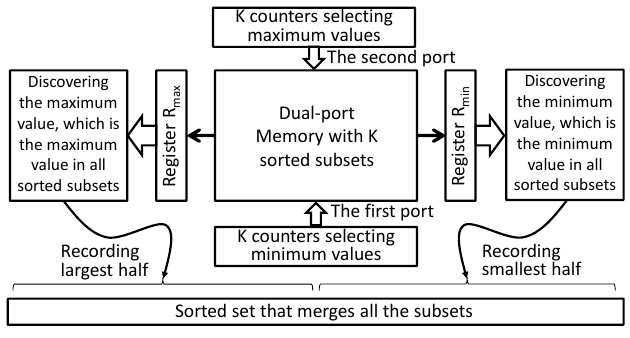
Fig. 4. Merging K sorted subsets. Since the first and the last steps are executed in different time slots, the first and the second levels of comparators shown in Fig. 1a can be reused in the networks of Fig. 6. It means that two lines of multiplexers are added: the first line selects either the set for sorting or R max ; and the second line selects either the first level of comparators (see Fig. 1a) or R min (note that one additional comparator is needed for R min ). Thus, the number of additional comparators for K subsets is equal to 2 × (2 0 + 2 1 + … + K /4). For our example in Fig. 6 K /4 = 4 and the number of additional comparators is 2 × (1 + 2 + 4) = 14. The circuit in Fig. 6 is combinational.